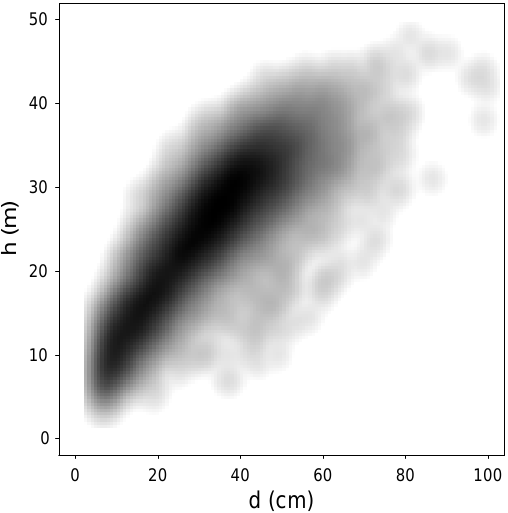
Figure 1. Smoothed scatterplot: height – diameter relationship of the model data.